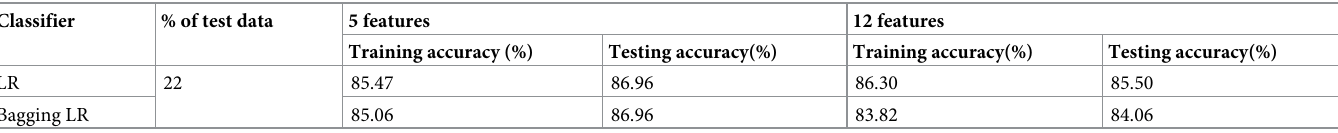
Table 11. Accuracies for LR and bagging LR. Classifier